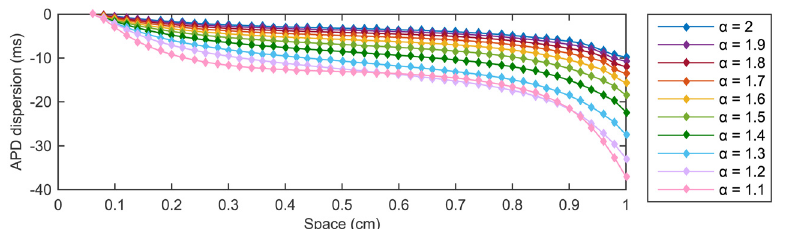
Fig 8. APD dispersion at forty-eight equally spaced nodes in [0.06 cm, 1 cm] for ten different values of α . For a fixed α , the APD is computed from the AP solution profile recorded at each considered node in the spatial interval. Dispersion of APD is then defined as the difference between the computed value of APD at that node and the maximum APD value recorded for the same value of α over the entire spatial